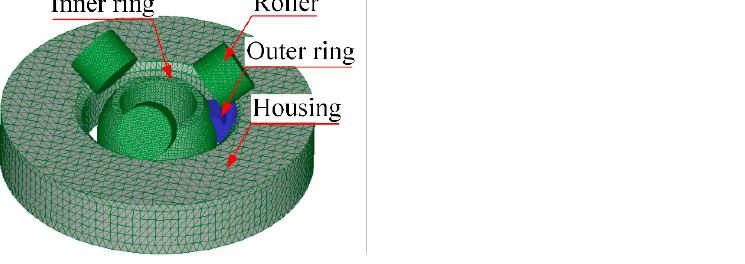
Figure 5. Schematic diagram of simulation model of the roller swaging process. Table 1. Main parameters of the MS14101-9 bearing.